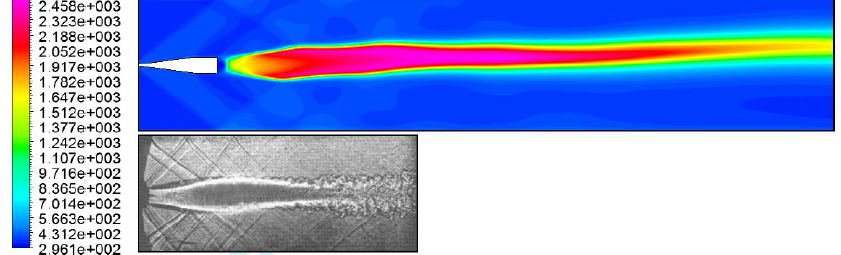
Figure 12. Reacting case comparison of DLR scramjet shadowgraph [12] ( bottom ) to CFD replicated flame temperature (K) ( top ).